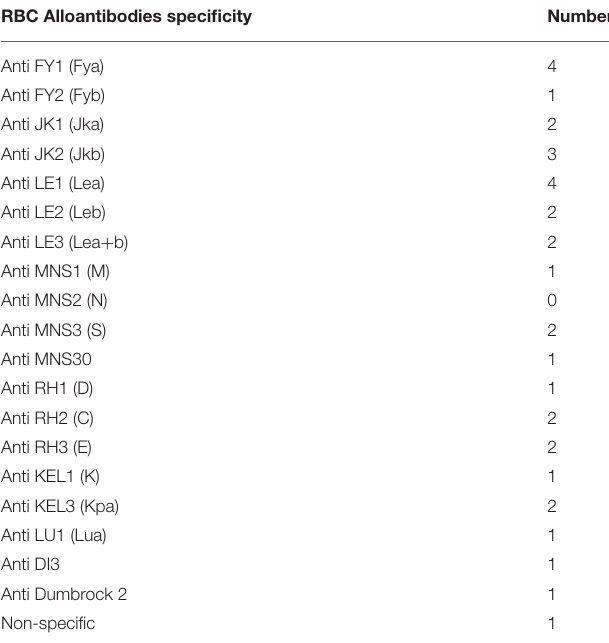
TABLE 2 | Specificities of RBC alloantibodies identified in the 13 patients with DHTR. RBC Alloantibodies